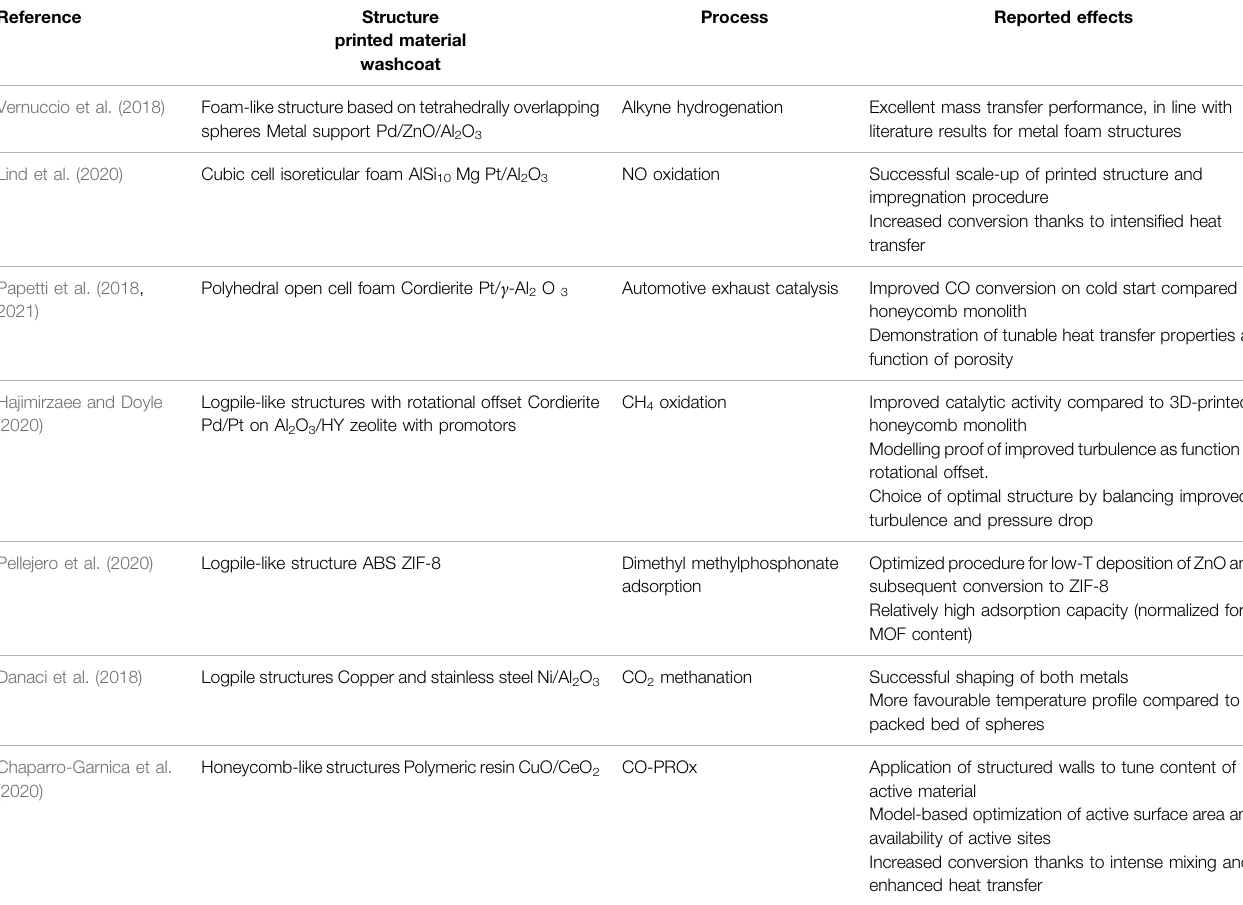
TABLE 3 | Overview of literature studies using coated 3D-printed